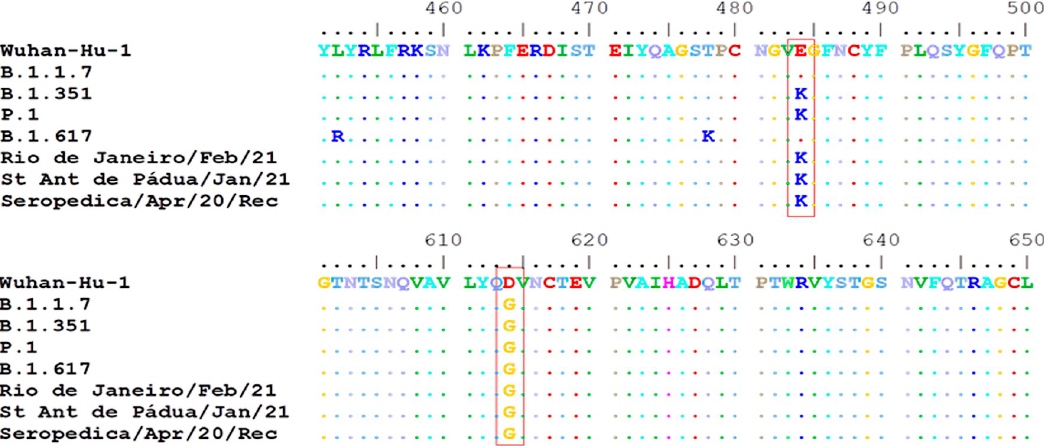
Fig 5. Sequence alignment showing amino acid substitutions E484K and